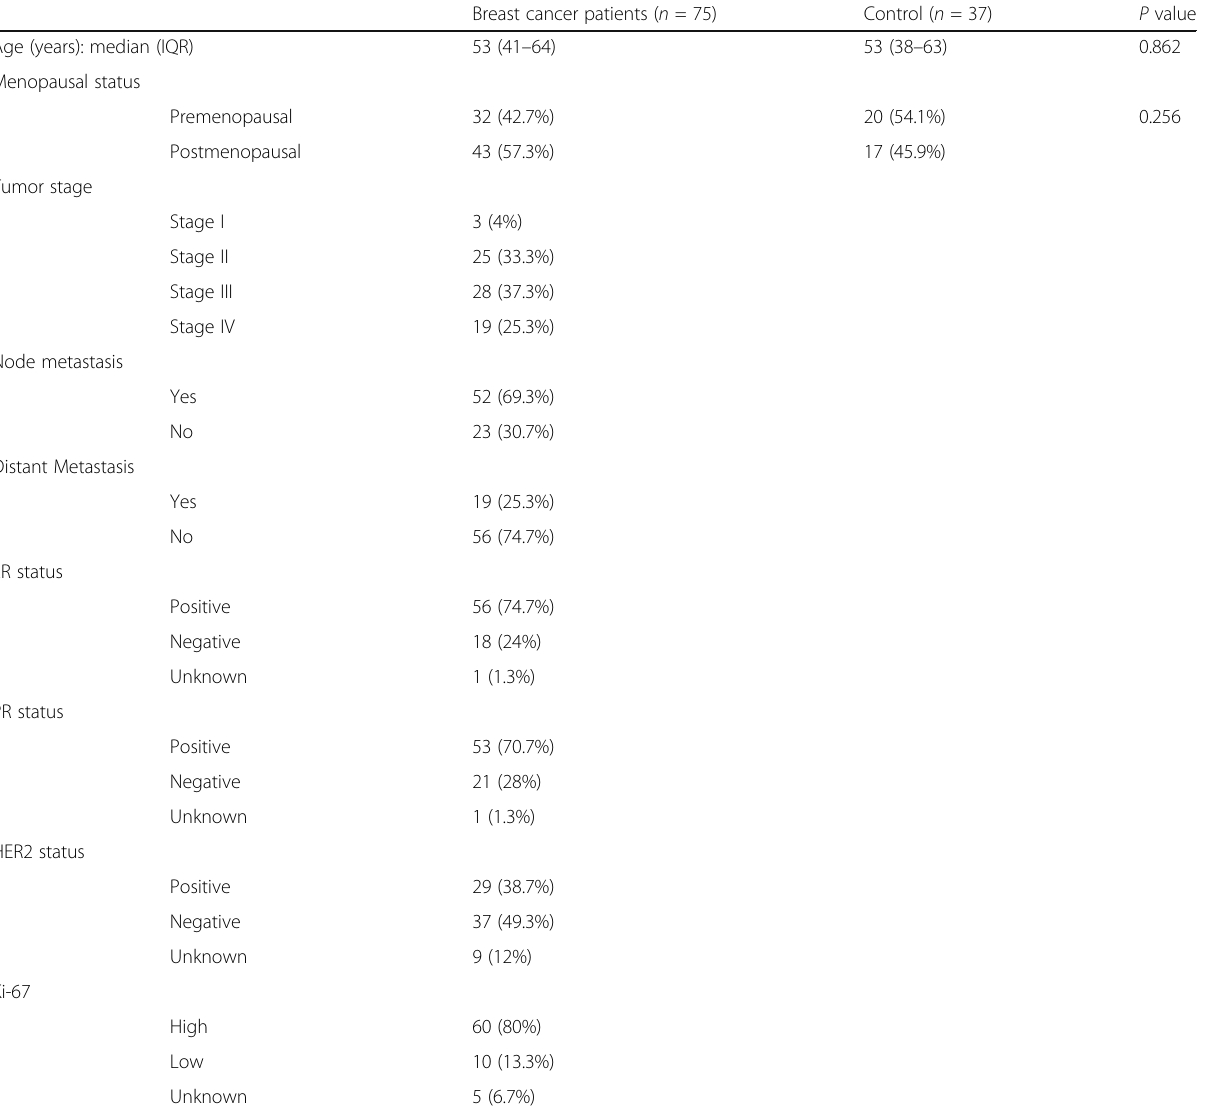
Table 1 Clinicopathologic and demographic characteristics of breast cancer patients and control groups Breast cancer patients ( n =